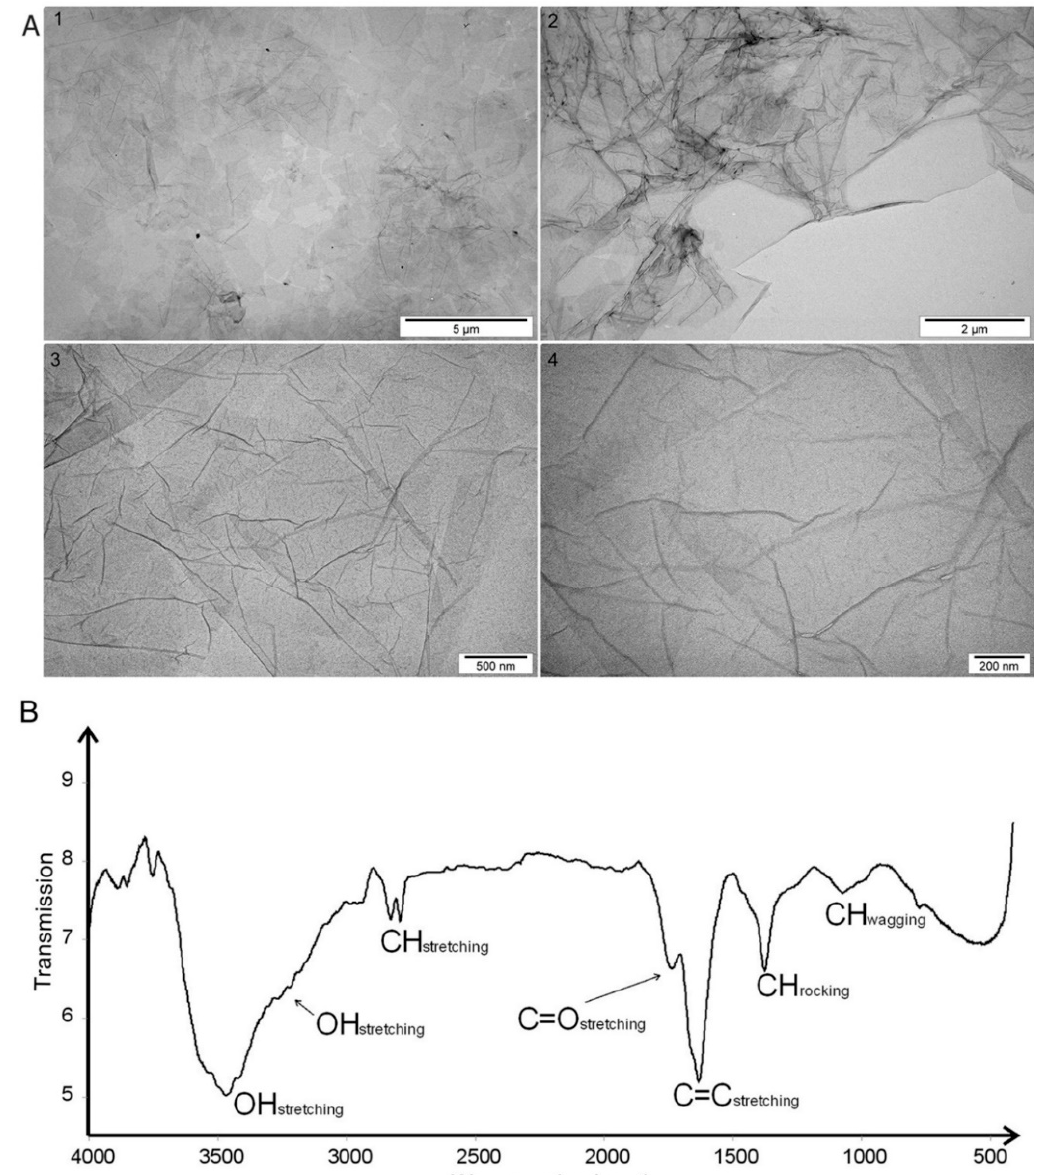
Figure 1. ( A ) Transmission electron microscopic images of graphene oxide flakes at increasing magnification: 1) 5,000, 2) 8,500, 3) 34,000, 4) 70,000; ( B ) Fourier Transform Infrared Spectroscopic spectrum of graphene oxide with the assignment of bands to appropriate vibrations of groups and bonds present in the sample.